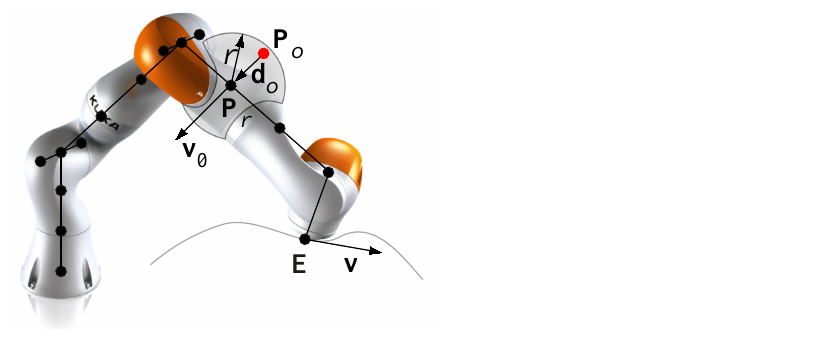
Figure 6. Linear velocity of the end-effector E and of the control point P r closest to the obstacle P o